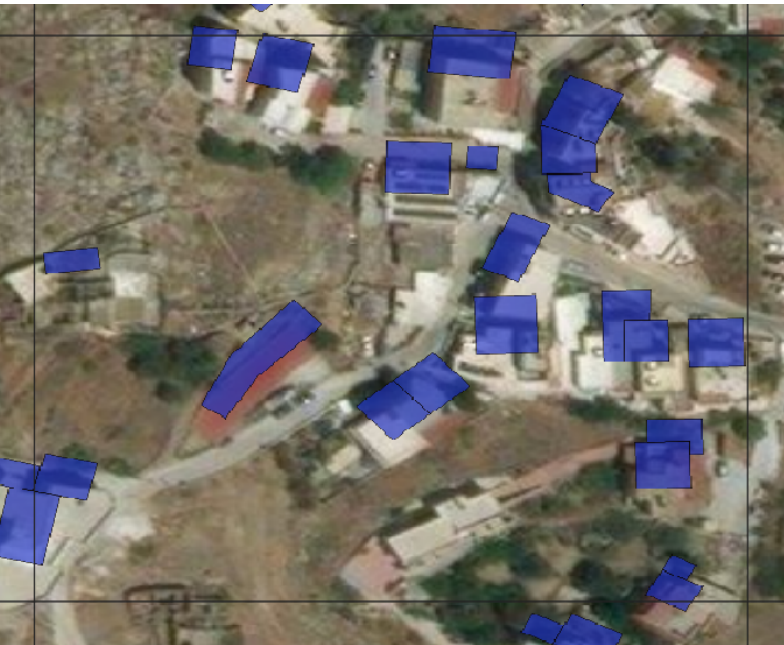
Figure 5. Example for a misalignment of the OSM building footprint layer and satellite imagery. The example is taken from the case study at Sirios. Table 5. Classification performance metrics for the completeness classification task for each site. TP, TN, FN and FP are the total number of tiles that were classified as true positives, true negatives, false negatives and false positives, respectively, by the aggregated voting of the